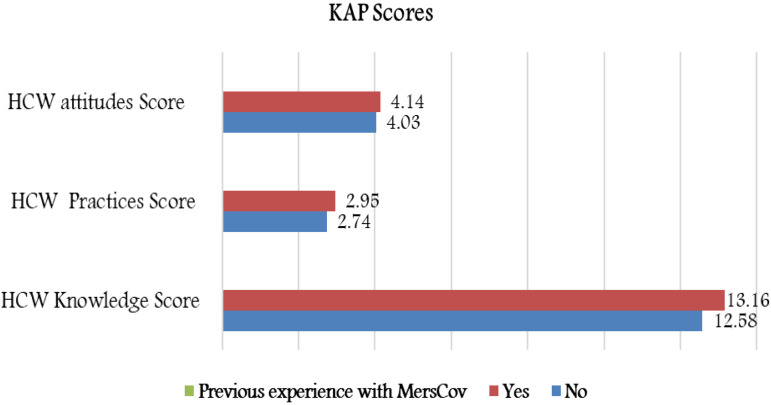
Mean KAP scores based on previous experience with MERS-CoV.